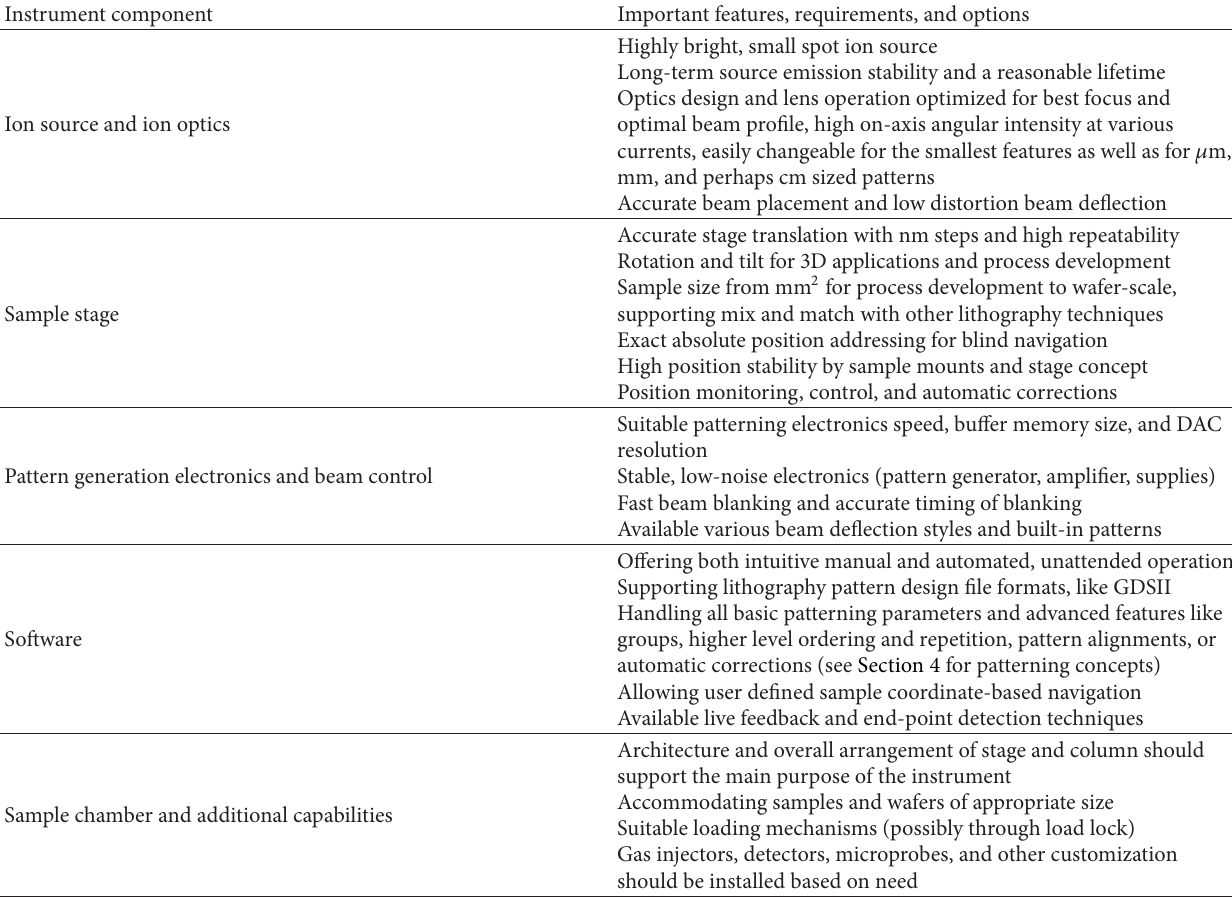
Table 2: Ion beam lithography instrument requirements and options to